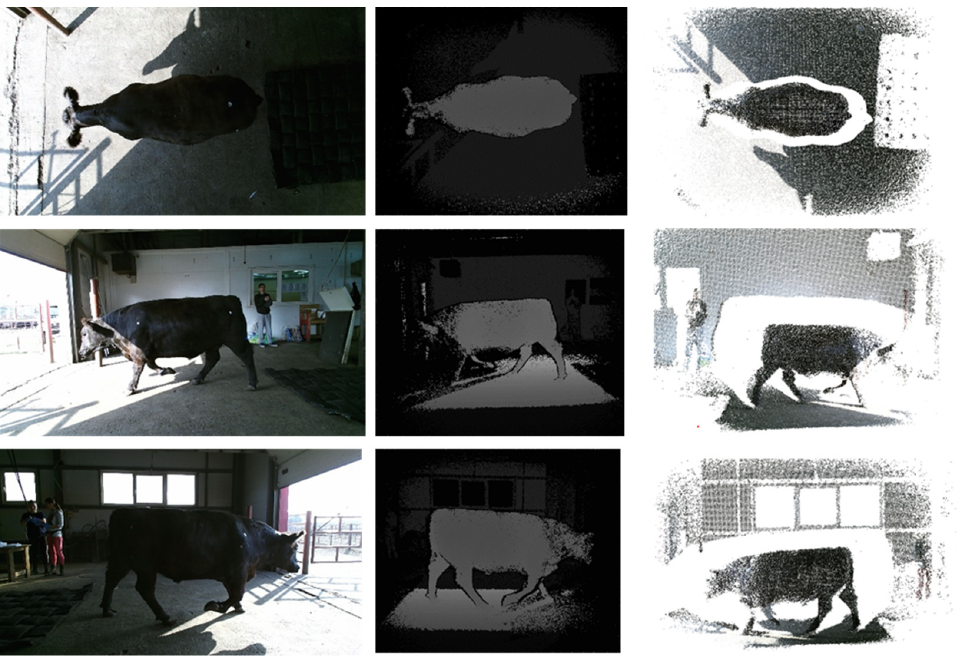
Figure 1. RGB images, depth maps, and point clouds of the cattle captured with three Kinect cameras.